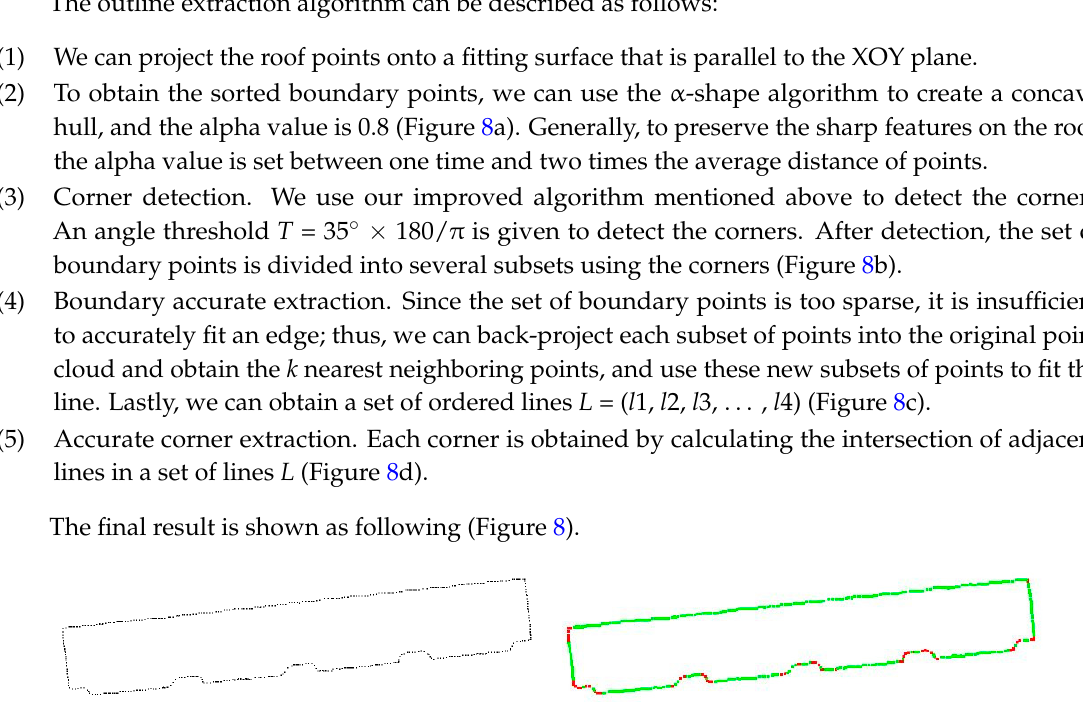
Figure 7. Process of outline extraction.